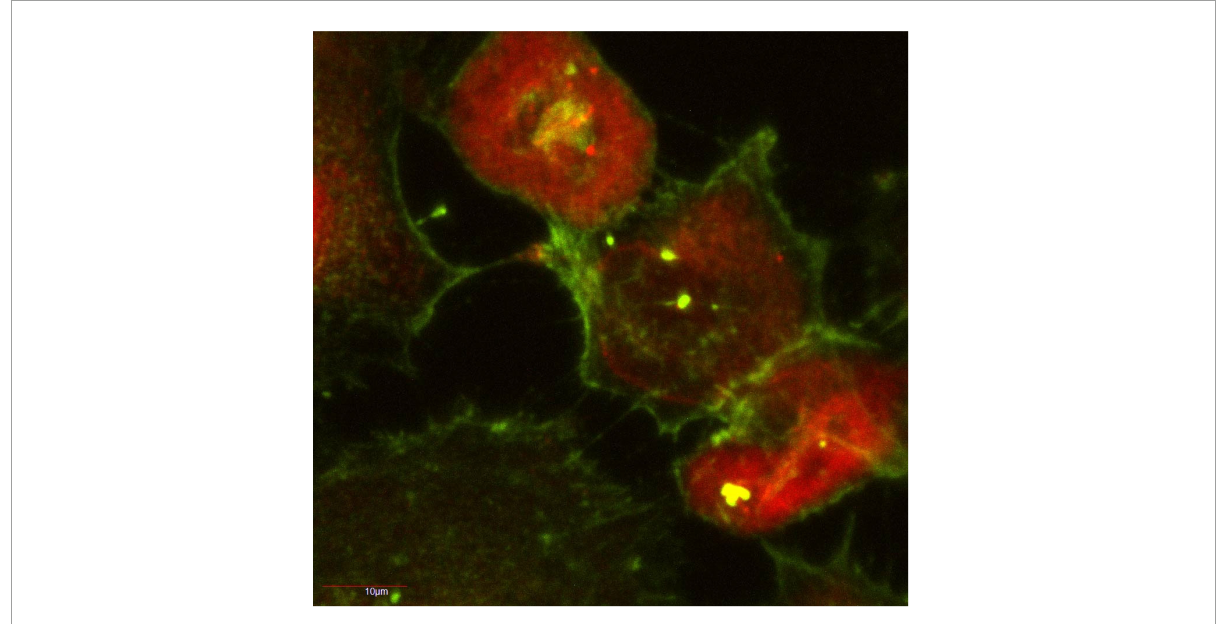
FIGURE1 Human medulloblastoma Daoy cells stably transfected with RFP-ATXN1(82) at 72 h in culture. The actin-positive TNT network is shown in green. RFP-ATXN1(82Q) aggregates are seen in several of the TNTs. A portion of this figure was published in Huang et al. (2022), CC BY